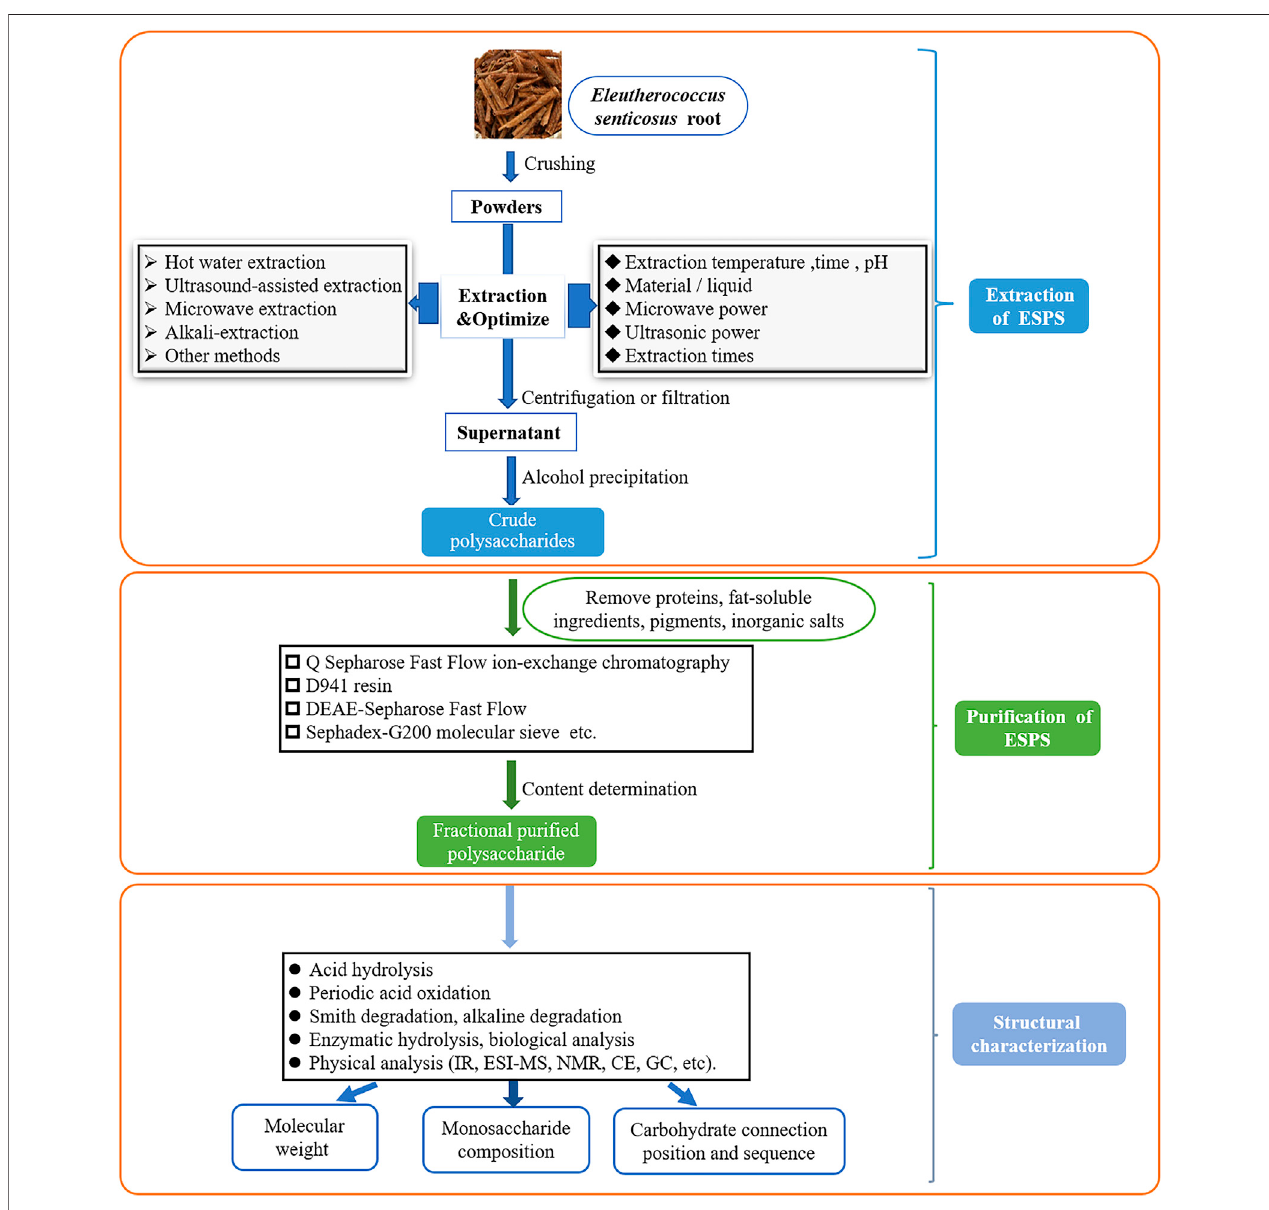
FIGURE 2 | Schematic diagram of extraction, puri fi cation and structural characterization of ESPS.